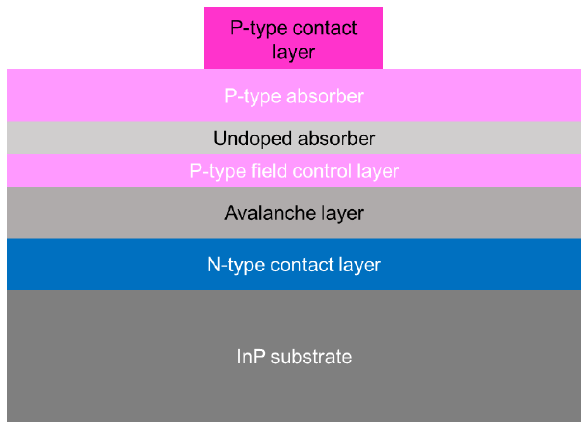
Figure 3. Schematic cross-section of mesa-type avalanche photodiodes (APD) with hybrid absorber that uses n-down and p-up structure.